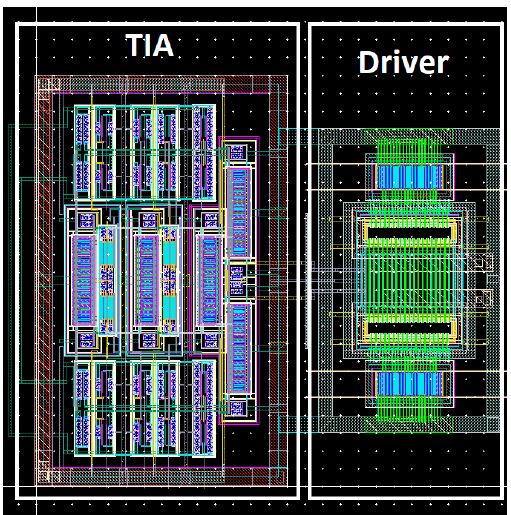
Figure 6. Layout of the active area of the transimpedance amplifier and the output driver.